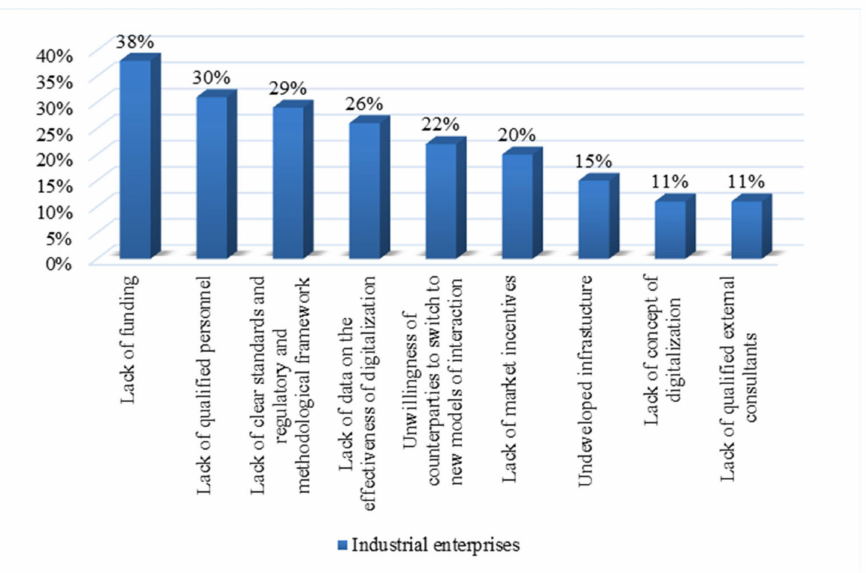
Figure 10. Existing obstacles to digital transformation in the work of enterprises of the manufacturing sector of the Republic of